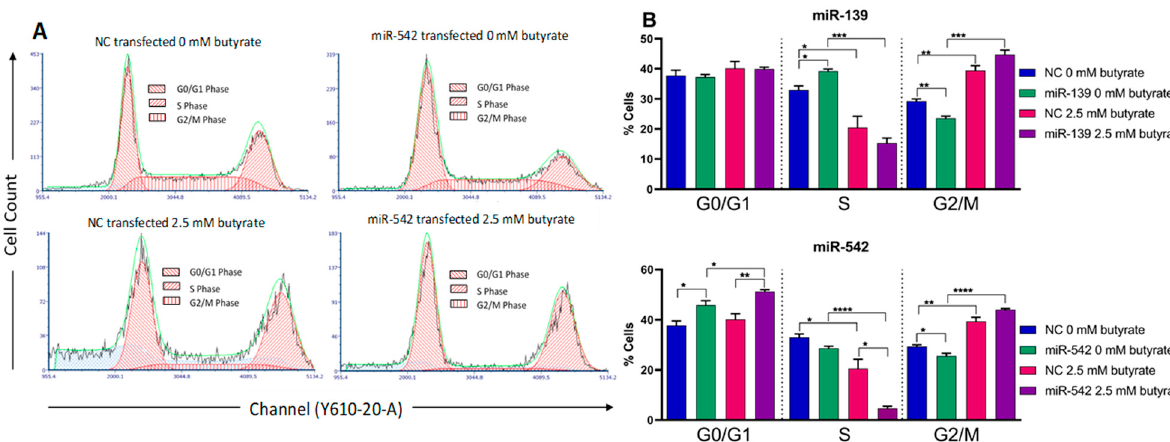
Figure 8. Flow cytometry analysis of the cell cycle in miRNA-transfected HCT116 cells after 24 h of butyrate treatment. ( A ) Examples of flow charts depicting cell cycle analyses of HCT116 cells reverse-transfected with control (NC) or miR-542 mimics for 48 h, followed by 24 h of treatment with 0 mM or 2.5 mM butyrate, over a 72 h post-transfection period. ( B ) Bar charts for cell cycle analysis of HCT116 cells reverse-transfected with miRNA mimics miR-139 or miR-542 for 48 h, followed by 24 h of treatment with 0 mM or 2.5 mM butyrate, over a 72 h post-transfection period. Cells were stained with propidium iodide, and cell percentage measured using the Cytoflex flow cytometer. The mean ± SEM ( n = 3) is shown. Significant results are indicated by * p < 0.05, ** p < 0.01, *** p < 0.001, **** p < 0.0001. NC = negative control mimic.